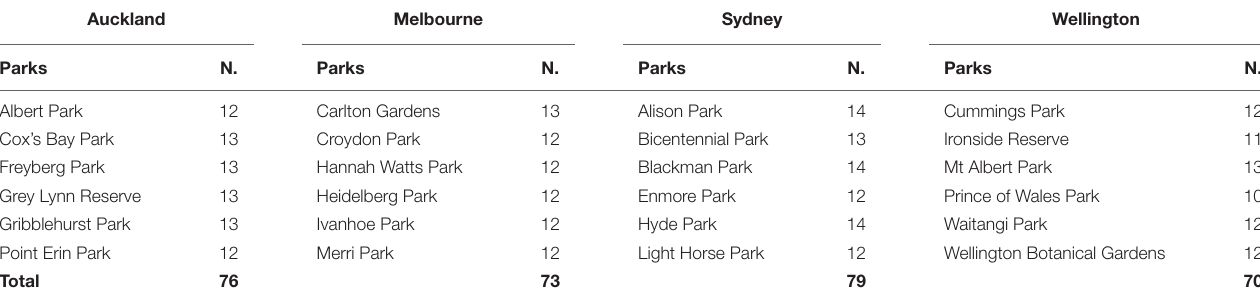
TABLE 1 | Park survey participants from each park across two park visits.